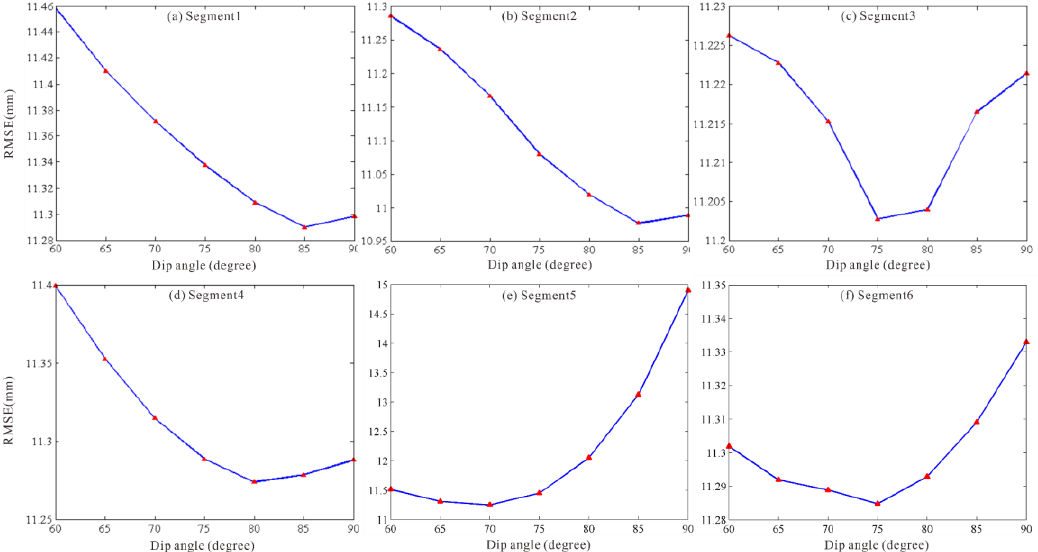
Figure 8. The trade-off curves between the model RMSEs and dip angles for the six segments of F1.